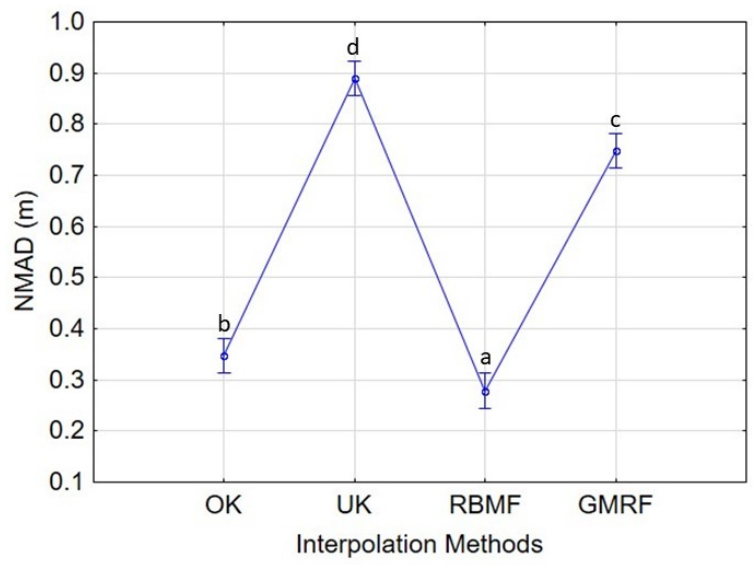
Figure 14. Plot of NMAD vs. interpolation method factor. Vertical bars denote 95% confidence Figure 14. P lot of NMAD vs. interpolation method factor. Vertical bars denote 95% con fi dence intervals. Different letters between interpolation methods indicate significant differences according intervals. Di ff erent le tt ers between interpolation methods indicate signi fi cant di ff erences according to Tukey’s test ( p < 0.05). to Tukey’s test ( p <